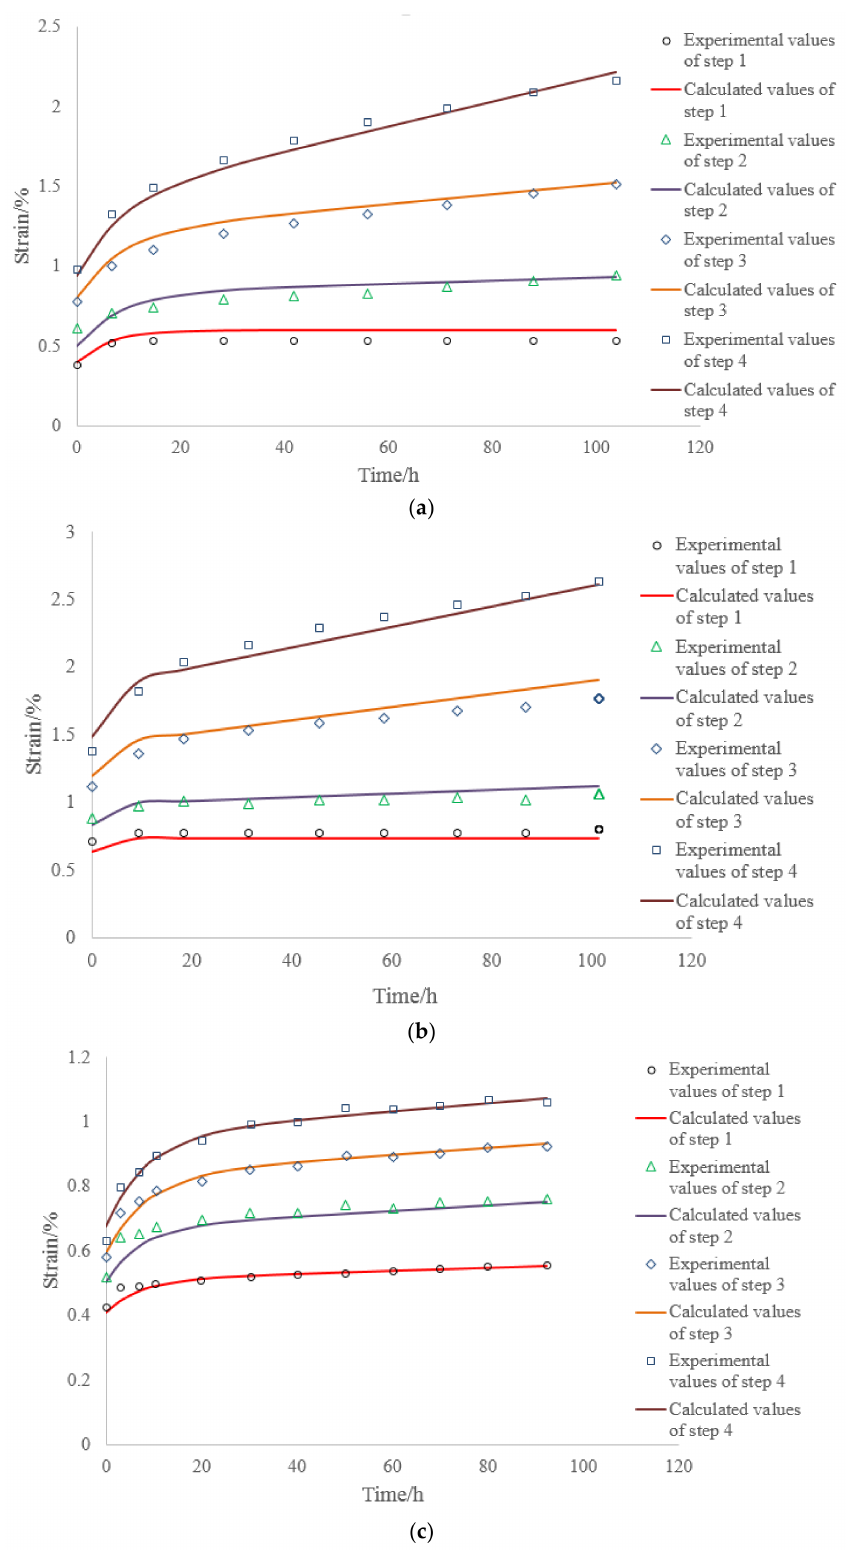
Figure 18. Comparison of the Nishihara model and experimental curves under multi-step